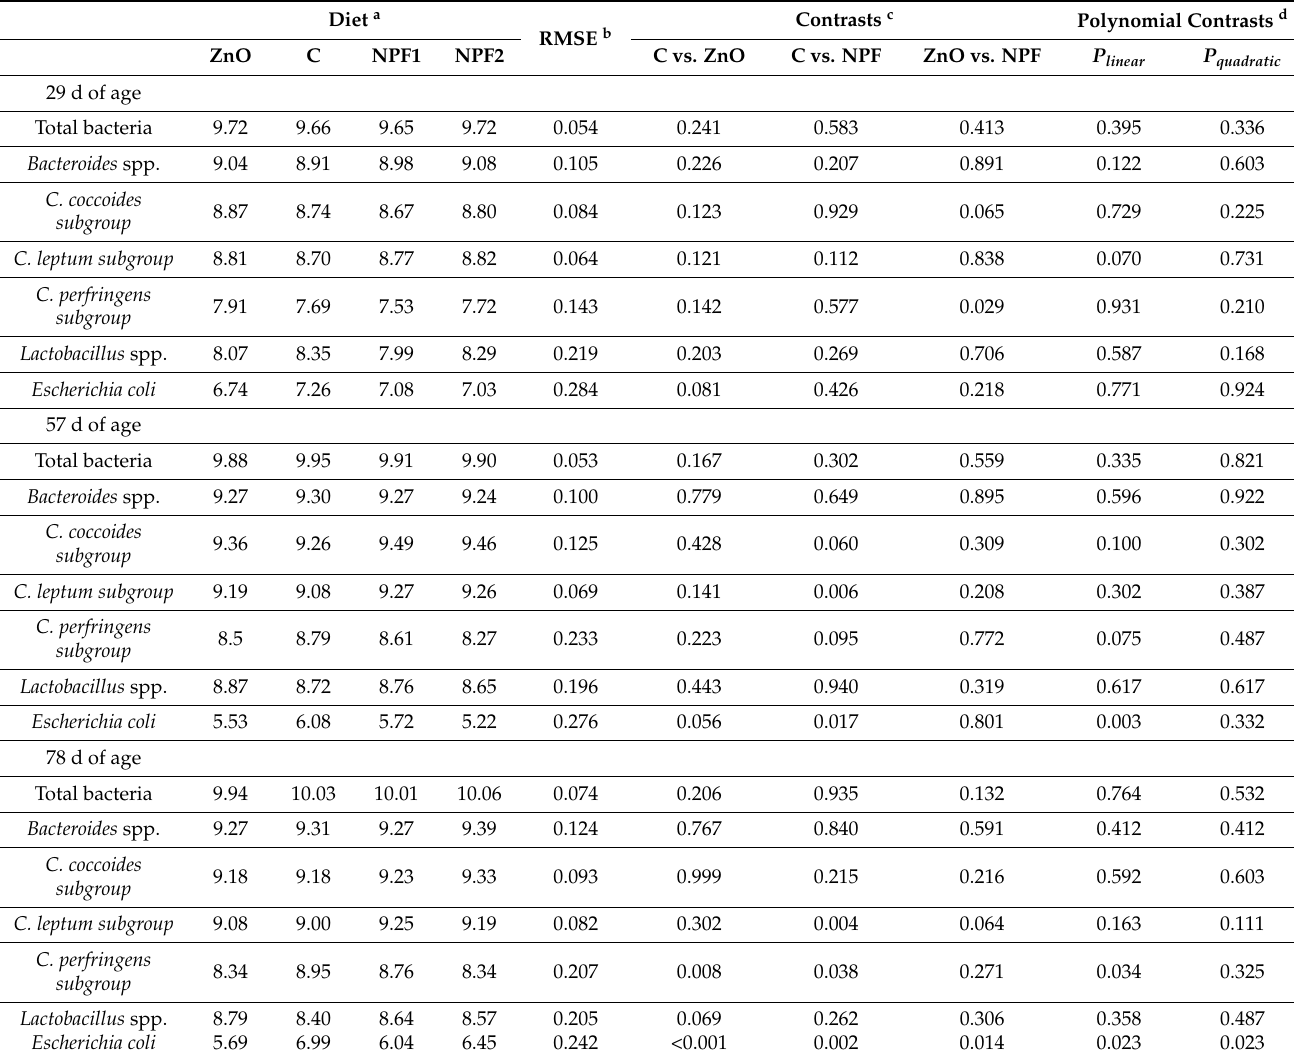
Table 6. Effect of diet on faecal microbiota composition (log cells/g wet faeces) of piglets at 29, 57 and 78 days of